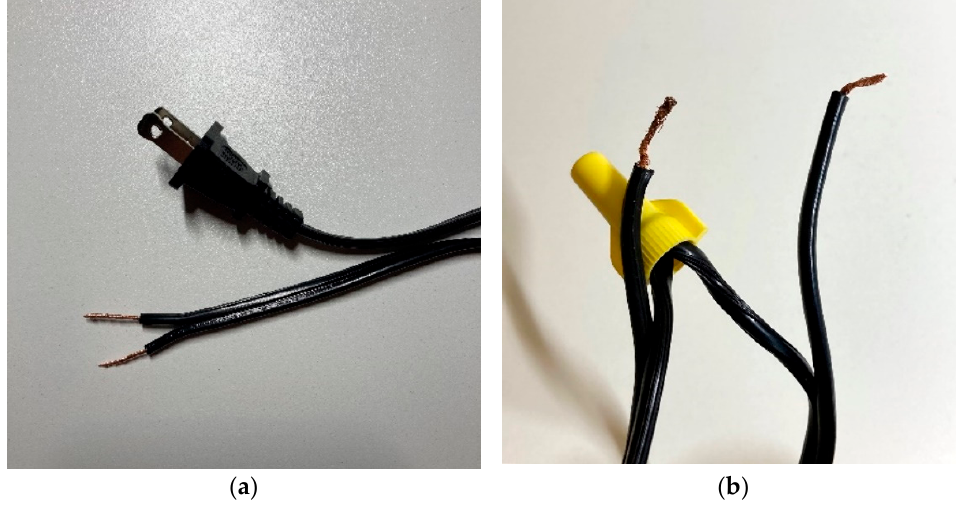
Figure 12. The power cable was prepared for connection to the relay. ( a ) First, it was cut in half. Only one wire needed to be cut, but both were cut in this case. ( b ) Next, one pair of wires was immediately re-joined with a wire nut.